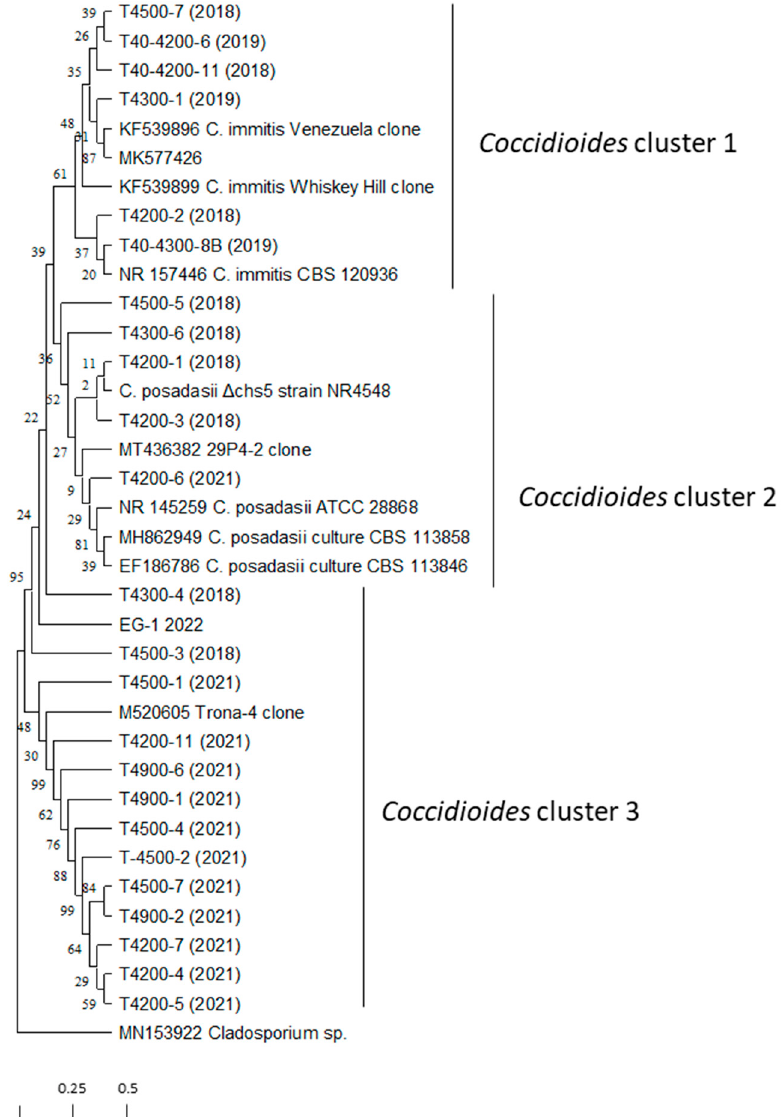
Figure 5. Phylogenetic tree of PCR amplicons obtained with primer pair EC3/EC100 together with close matches in the GenBank database ( Cladosporium sp. was used as outgroup). The evolutionary history was inferred using the neighbor-joining method. The percentage of replicate trees in which the associated taxa clustered together in the bootstrap test (1000 replicates) is shown next to the branches. The evolutionary distances were computed using the maximum composite likelihood method and are in the units of the number of base substitutions per site. Evolutionary analyses were conducted in MEGA11. All ambiguous positions were removed for each sequence pair (pairwise deletion option). There were a total of 577 positions in the final dataset.